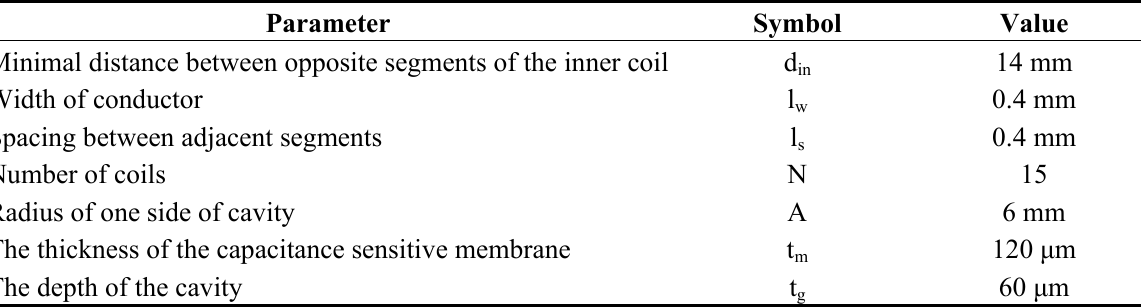
Table 1. Geometrical structure parameters of the inductor and